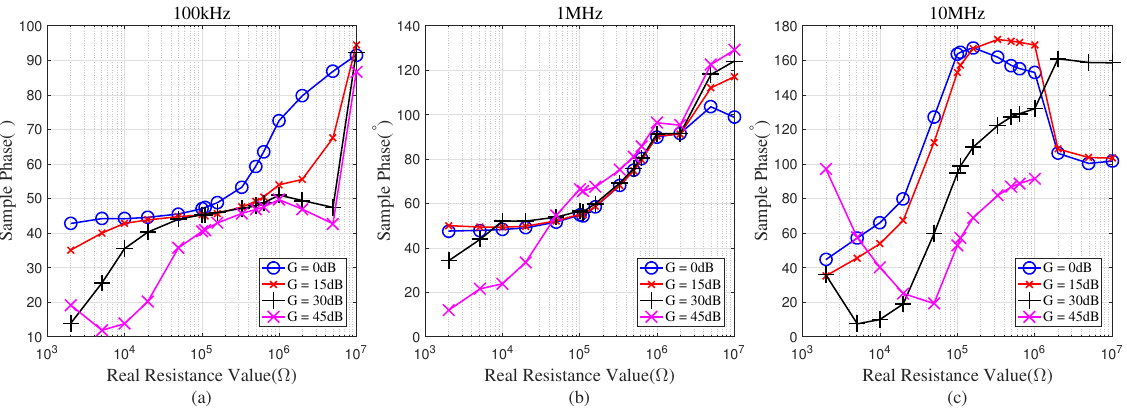
Figure 8. The measured resistance values in different resistor measurements when the excitation signal frequency is ( a ) 100 kHz, ( b ) 1 MHz and ( c ) 10 MHz, respectively. G stands for the gain of receiving chain.